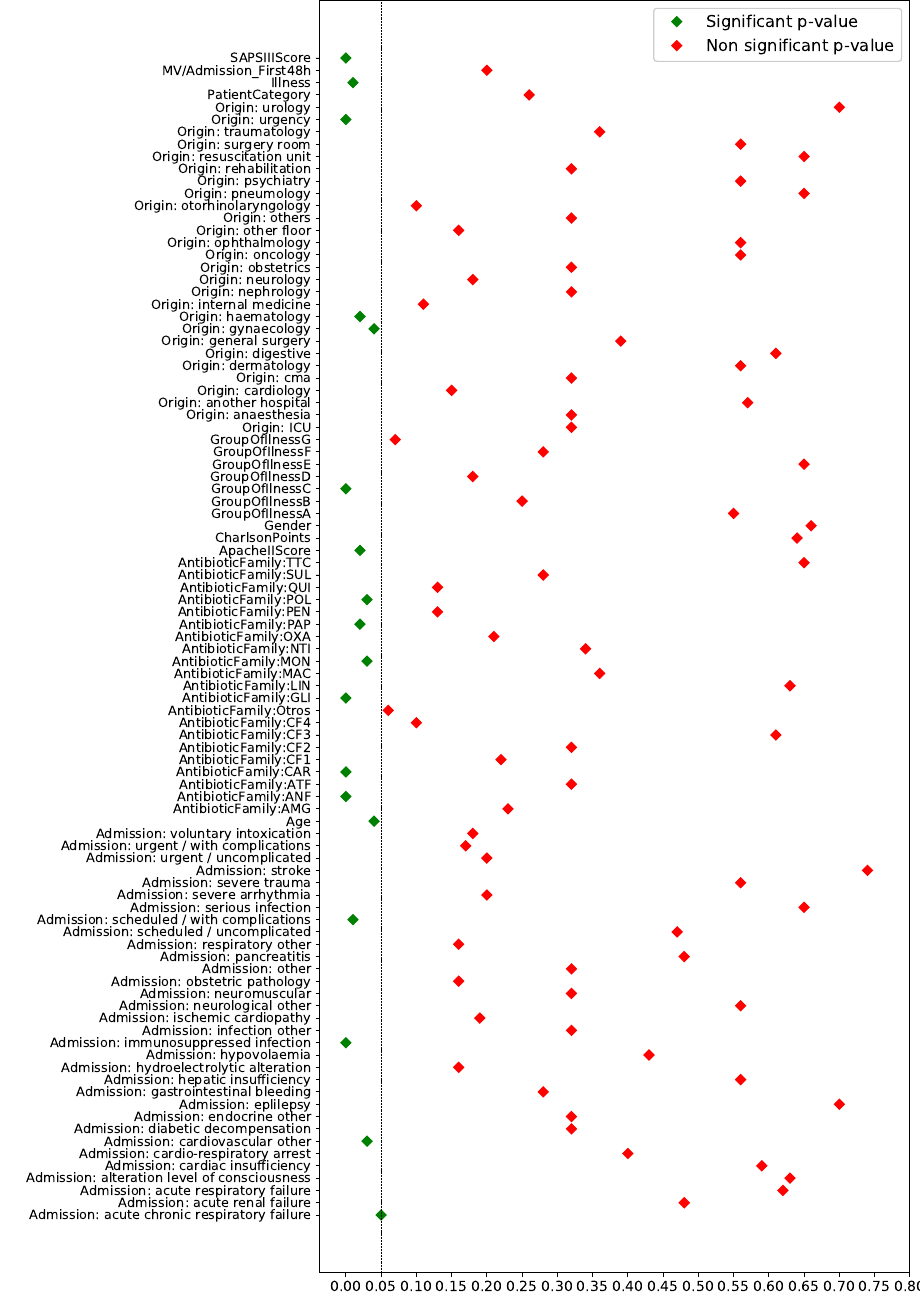
Figure 9. Average of the p -values for the 95 initial features when considering bootstrap and the proportion/median test for binary and numerical features, respectively, with a significance level of α =